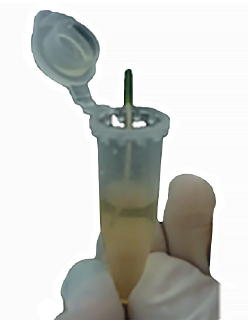
Figure 1. Microbiologic collection with a sterile paper